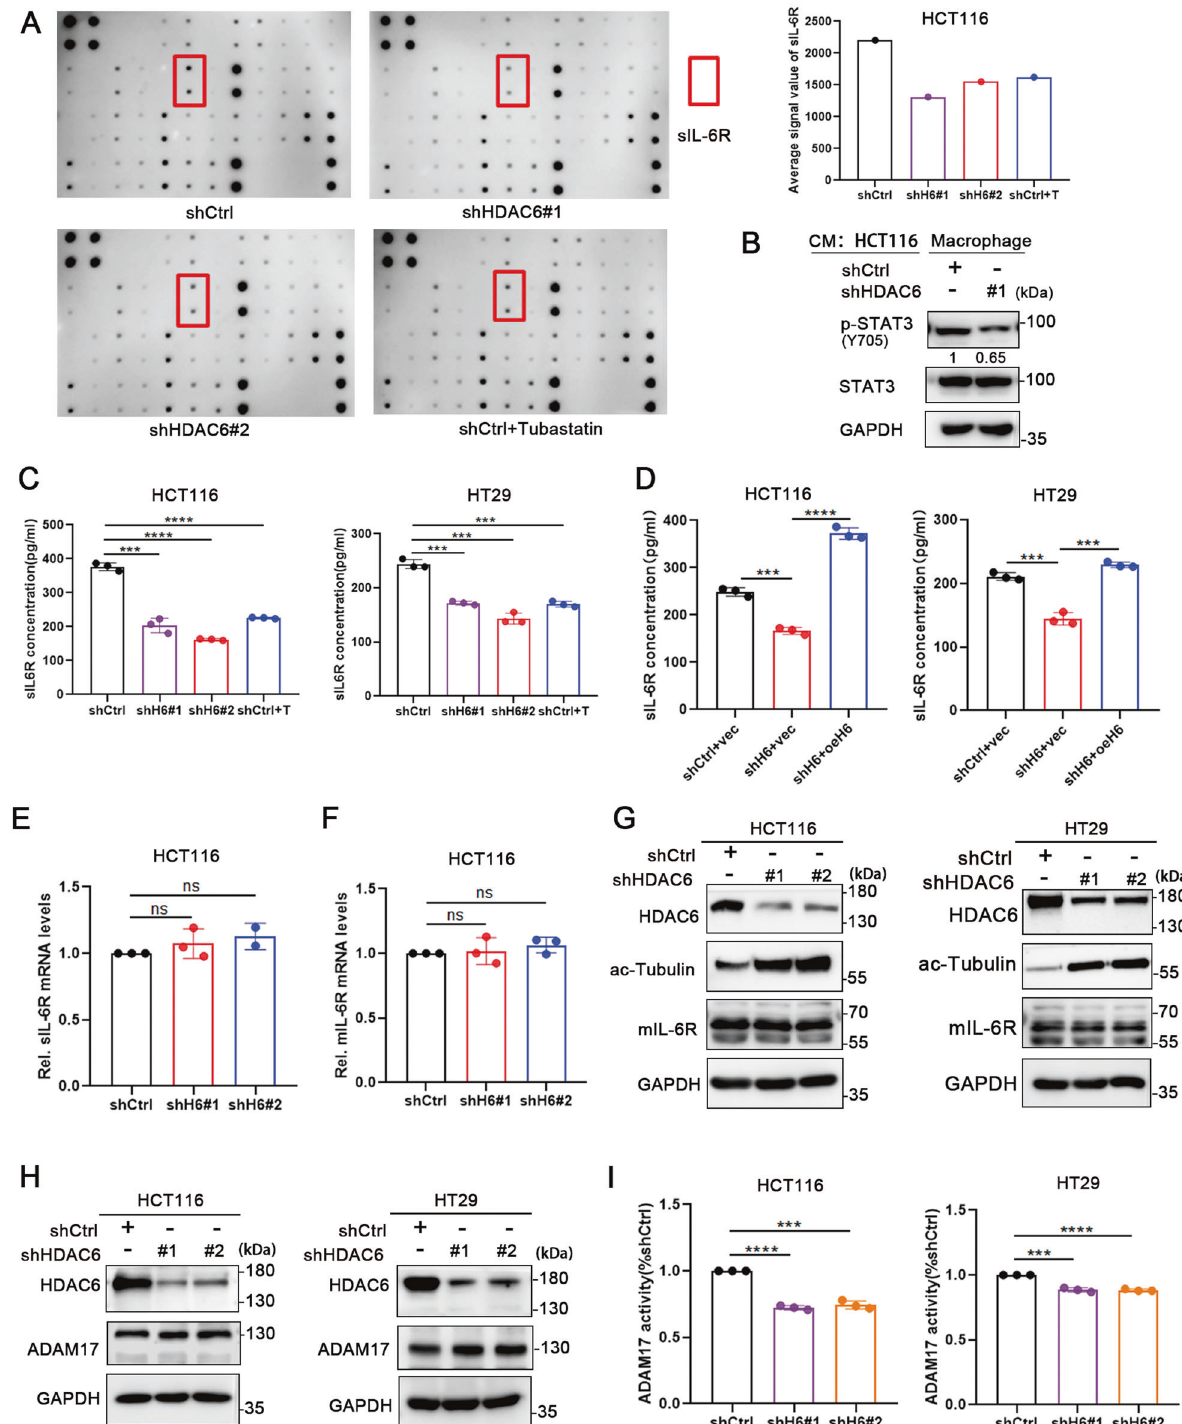
Fig. 2 HDAC6 promotes sIL-6R release in colon cancer cells by increasing the activity of ADAM17. A Left, analysis of cytokine levels in the culture medium of HCT116 cells stably expressing shCtrl or shHDAC6 or treated with the HDAC6 inhibitor Tubastatin A HCl by using the AAH- INF-3 RayBiotech antibody chip. Right, the quanti fi ed average signal value of sIL-6R. B Western blot analysis of the total protein expression and phosphorylation level of STAT3 in macrophages cocultured with HCT116 cells. C , D SIL-6R contents in the culture medium of HCT116 and HT29 cells in the indicated groups determined by ELISA. E , F qRT-PCR analysis of the mRNA expression levels of mIL-6R and sIL-6R in HCT116 cells with stable HDAC6 knockdown. G Western blot analysis of mIL-6R protein levels in HCT116 and HT29 cells with stable knockdown of HDAC6. H Western blot analysis of ADAM17 protein levels in HCT116 and HT29 cells with stable HDAC6 knockdown. I Detection of the cleavage activity of ADAM17 (TACE Substrate IV, Fluorogenic) in G . AD17 is the abbreviation of ADAM17; H6 is the abbreviation of HDAC6; T is the abbreviation of Tubastatin A HCl. CM is the abbreviation of conditioned medium. Data were shown as the mean ± SD of three independent experiments; ns no signi fi cance, *** P < 0.001; **** P < 0.0001.